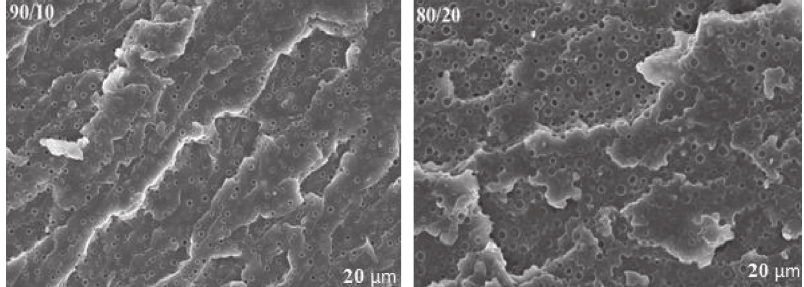
Figure 2: FE-SEM of the sample epoxy Epikote 240/epoxidised linseed oil (EP/ELO) images with ratios 90/10 and